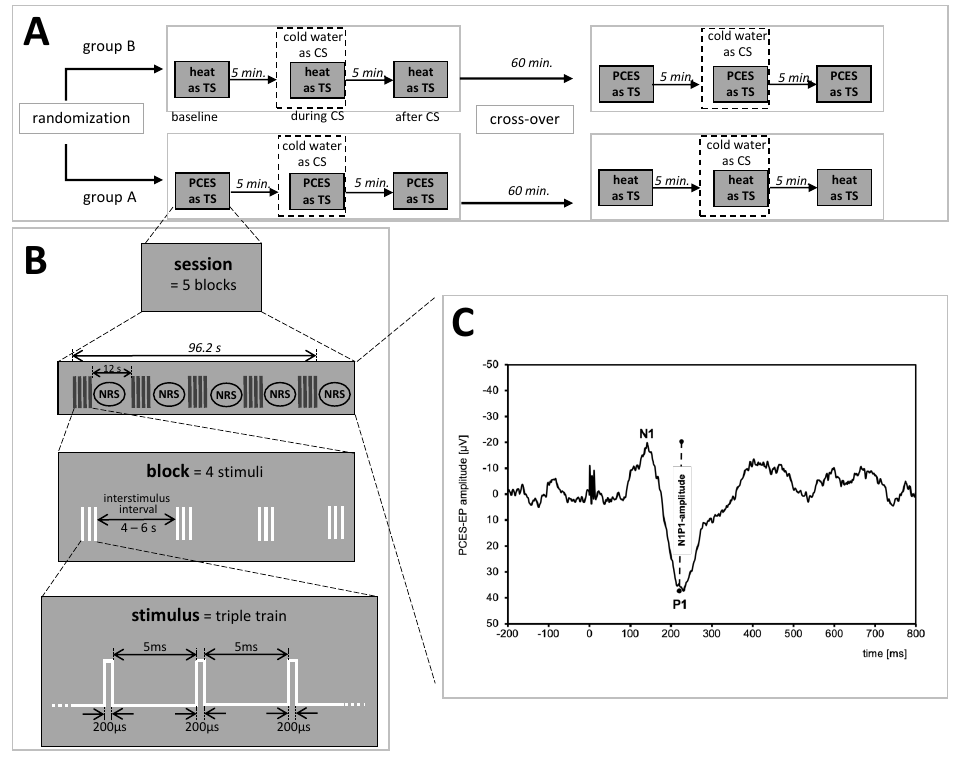
Figure 1. Study design. ( A ) Timeline of experimental procedure, ( B ) paradigm for electrical stimulation and ( C ) evoked potential after painful cutaneous electrical stimulation (PCES-EP) with N1 and P1 peaks recorded over Cz of one subject. TS: test stimulus; CS: conditioning stimulus; NRS: assessment of the pain intensity during painful cutaneous stimulation on the numerical rating